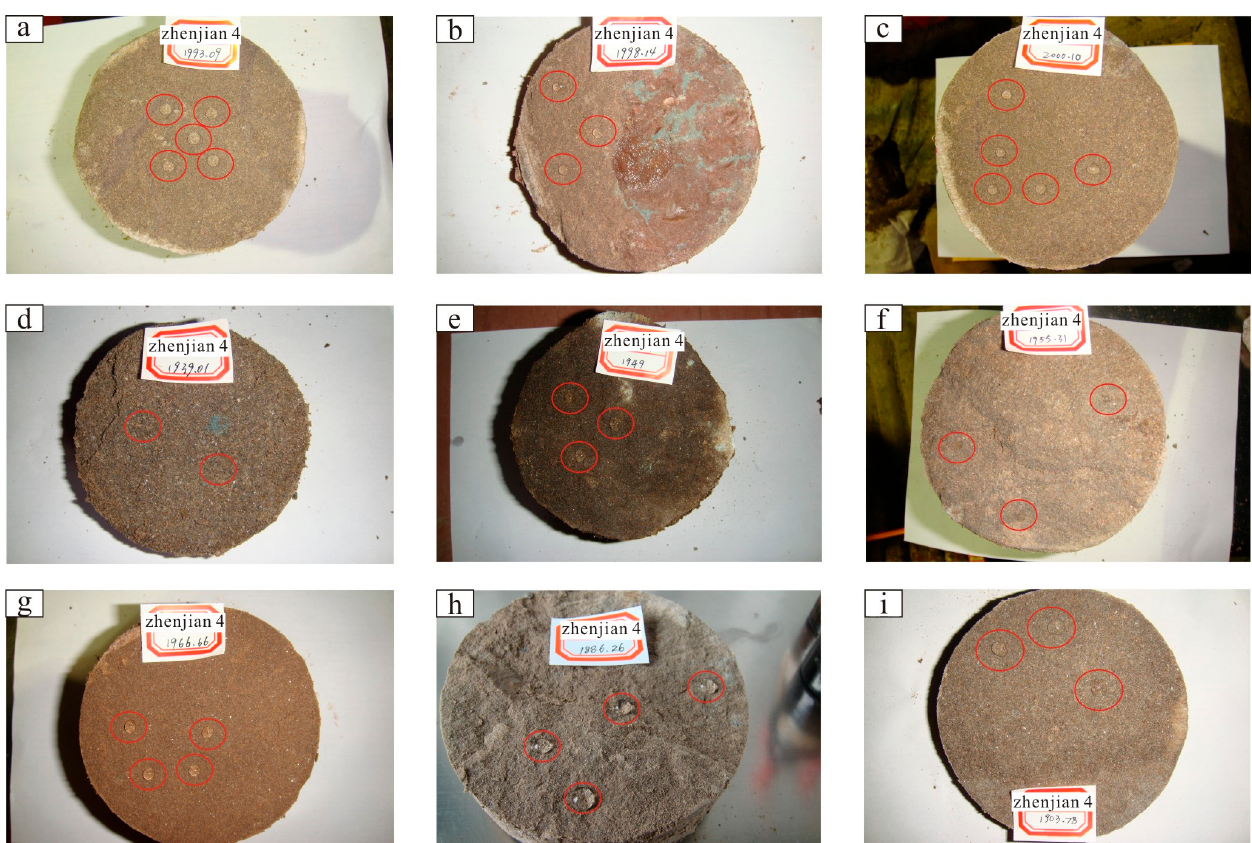
Figure 4. Drip characteristics of core section sand body in Zhenjian 4. ( a ) The Zhenjian 4 well (1993.09 m) shows that the core is cylindrical after water dripping, and no ‐ drip penetration was observed; ( b ) the Zhenjian 4 well (1998.14 m) shows that the core is cylindrical after water dripping, and no ‐ drip penetration was observed; ( c ) the Zhenjian 4 well (2000.1 m) shows that the core is cylindrical after water dripping, and no ‐ drip penetration was observed; ( d ) in the Zhenjian 4 well (1939.01 m), fast ‐ drip penetration was observed; ( e ) in the Zhenjian 4 well (1949 m), no ‐ dripping was observed; ( f ) in the Zhenjian 4 well (1955.31 m), fast ‐ drip penetration was observed; ( g ) in the Zhenjian 4 well (1966.66 m), no ‐ drip penetration was observed; ( h ) in the Zhenjian 4 well (1886.26 m), no ‐ drip penetration was observed; ( i ) in the Zhenjian 4 well (1903.78 m), water dripping was noted to be slight and hemispherical.